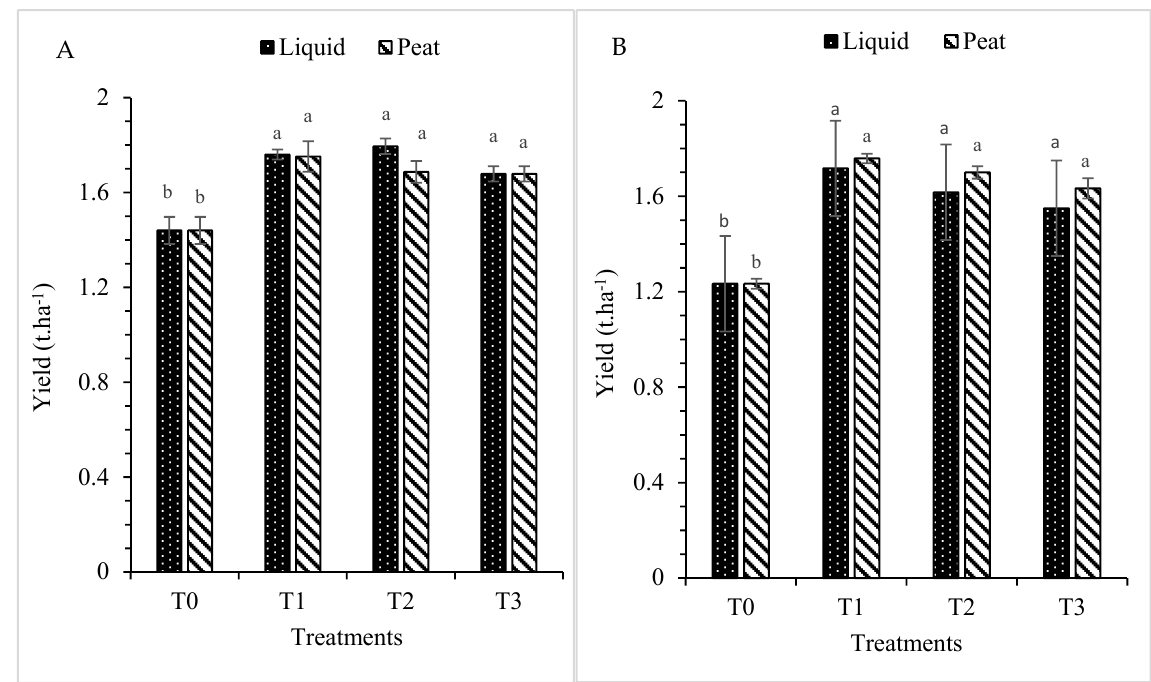
Figure 6. Yield of soybean plants subjected to liquid formulation (T0 = 0 mL, T1 = 150 mL, T2 = 300 mL and T3 = 150 mL) and peat formulation of Bradyrhizobium japonicum (T0 = 0 mg, T1 = 250 mg, T2 = 500 mg and 150 mL) in bioclimatic zone (( A ) = Bronkhorspruit/Gauteng) and (( B ) = Hartbeesfoein/North West province). Bars sharing a letter are not significantly different (Lsd zone A) = 0.209 and (Lsd zone B) = 0.108. Data are means ± standard errors.